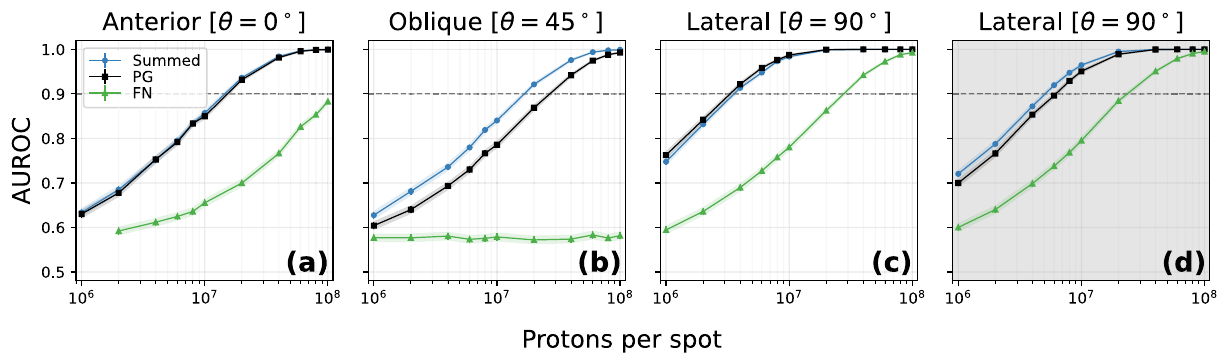
Figure 7. AUROC curves for the clinical case at three different orientations of the NOVCoDA with respect to direction of the incident proton beam. The figure summarizes the calculated AUROC values using only FN and only PG distributions reconstructed using the LM-MLEM algorithm as well as for the combination of FN and PG distributions for an orientation of θ = 0 ◦ ( a ), θ = 45 ◦ ( b ) and θ = 90 ◦ ( c ), as well as the θ = 90 ◦ case with the estimated effects of time, energy, and position resolutions (and segmentation of a realistic detector) included in ( d ). Statistical uncertainties in terms of one standard deviation of the AUROC are also shown explicitly as a narrow band around each